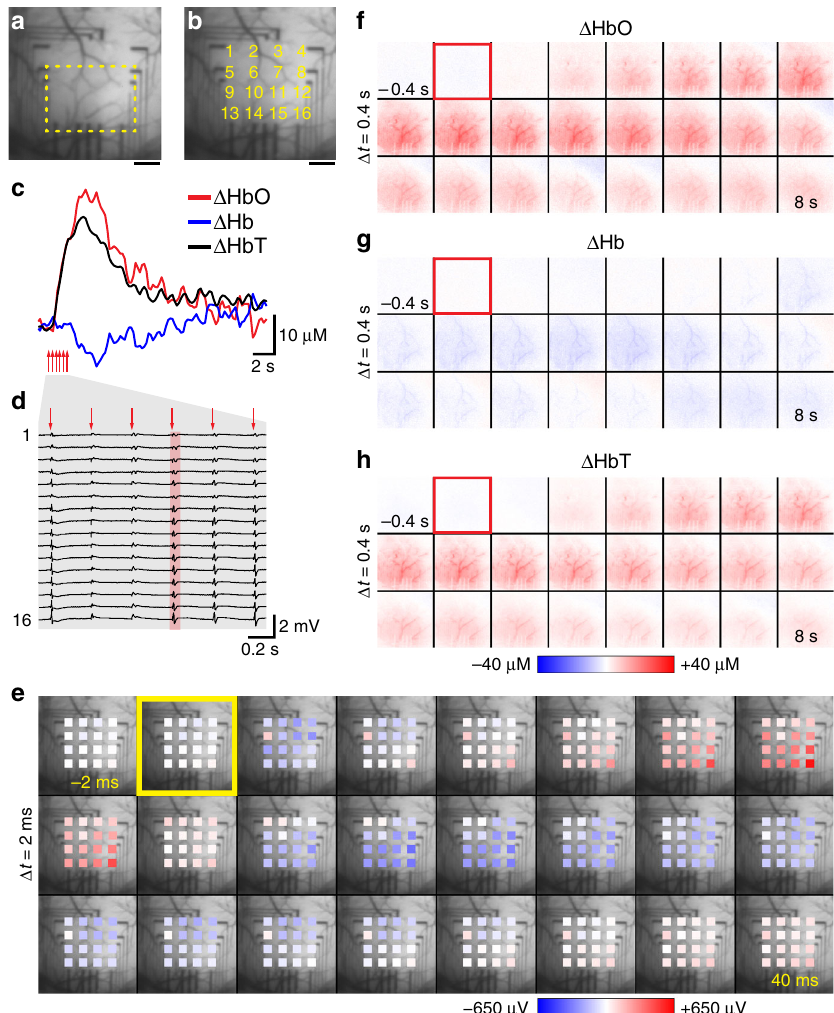
Fig. 7 Combination of macroscopic hemodynamic optical imaging with electrical recordings. Light absorption at six wavelength ranges (560 – 610 nm, 10 nm step size) was recorded with a CCD camera at an acquisition frequency of ca. 18 Hz. Absorption at these wavelengths was converted to concentrations of oxyhemoglobin (HbO), deoxyhemoglobin (Hb), and total hemoglobin (HbT) measured as changes relative to pre-stimulus baseline. A train of six electric pulses (1 mV for 2 s at 3 Hz, pulse width: 300 µ s) was delivered to the whisker pad. a Image of the exposure and graphene microelectrode array with region of interest (yellow line) used for evaluation of hemodynamic signals. b Image of the exposure with location and numbering of graphene electrodes. Scale bars for a and b , 500 µ m. c Changes in HbO, Hb, and HbT in response to electrical whisker pad stimulation (average of 10 trials across the region of interest shown in a ). d Corresponding recordings from the graphene microelectrode array; voltage traces recorded during stimulation period are shown (average of 10 trials; channel positions as indicated in b ). e Spatiotemporal analysis of the electrical response to one electrical stimulus (red highlight in d